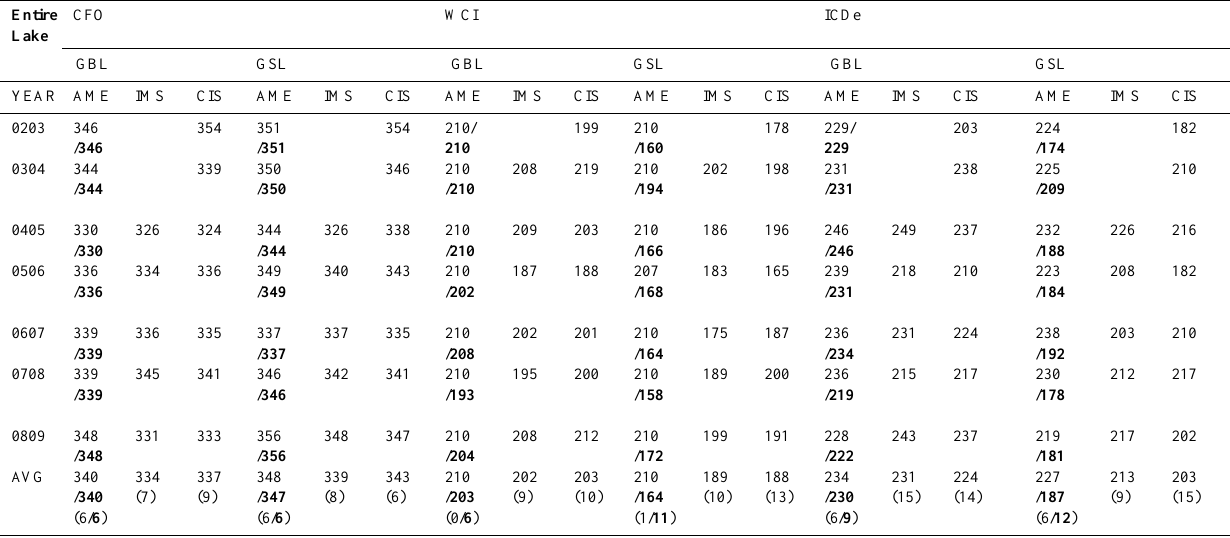
Table 9. Comparison of ice phenology variables (CFO, WCI, and ICDe) daily derived from AMSR-E (AME) and NOAA/IMS (IMS) products, as well as weekly-derived from Canada Ice Service (CIS) product for GBL and GSL (2002–2009). Values within confidence regions in bold. Standard deviation in